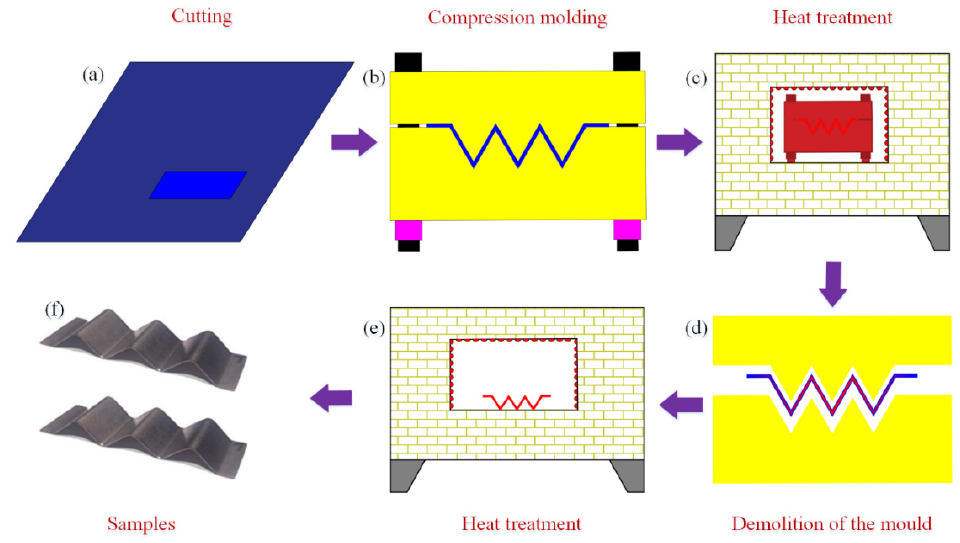
Figure 2. Corrugated samples preparation process: ( a ) take sample, ( b ) compression molding, ( c ) heat treatment, ( d ) demoulding, ( e ) secondary heat treatment, ( f ) samples.